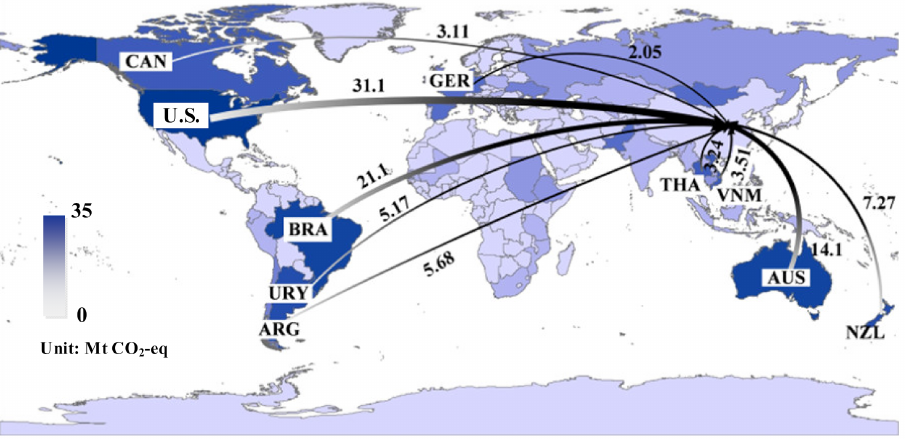
Figure 7. Major GHG emission flows embodied in China’s import of agricultural products in